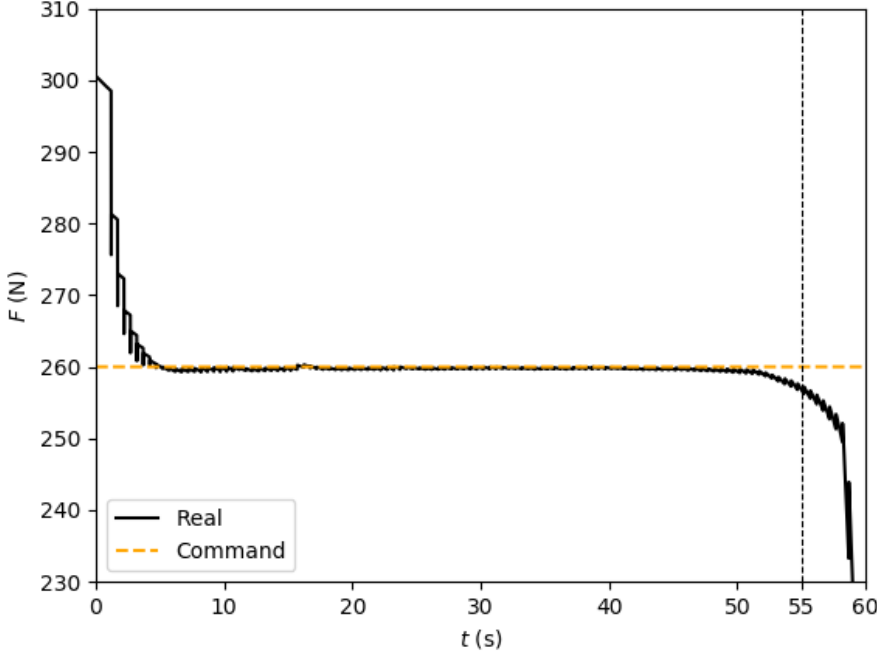
Figure 17. Thrust profile, feedback with complete regulation law, case